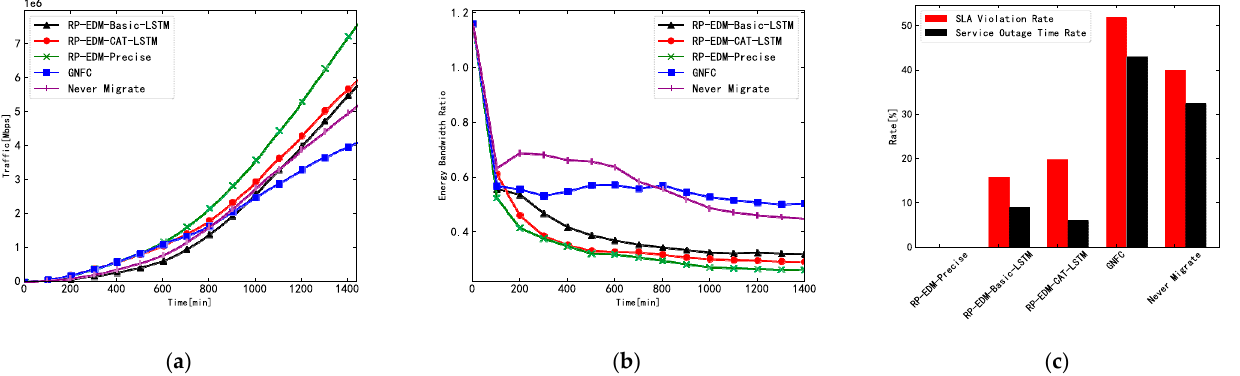
Figure 4. Comparison of the result of RP-EDM when using Basic LSTM and CAT LSTM, GNFC and Never Migrate policy: ( a ) total service traffic; ( b ) energy bandwidth ratio; ( c ) SLA violation rate and service outage time rate.